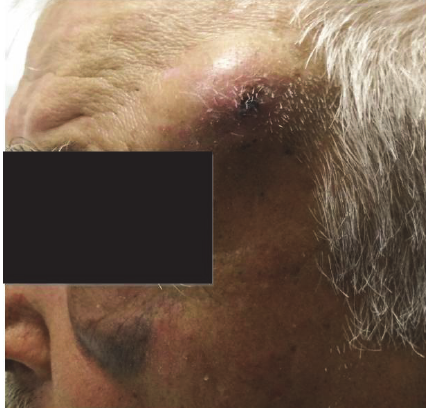
Figure 2: Pseudoaneurysm with hematoma extended into the periorbital space.